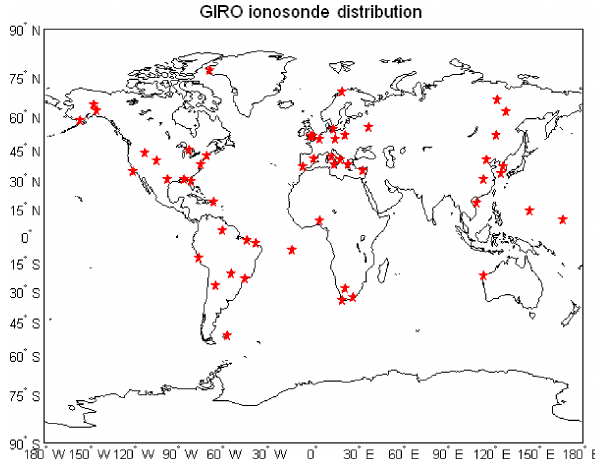
Figure 3. The distribution of ionosonde stations. The data of 54 ionosonde stations can be obtained from